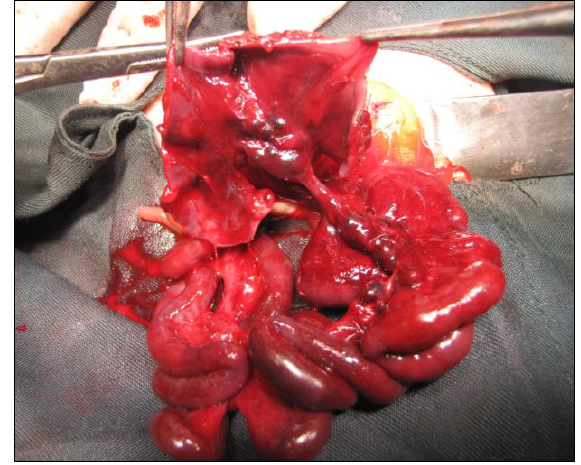
Figure 1: Preparation of seromuscular flap from isolated distal 4 cm of proximal atretic end of small